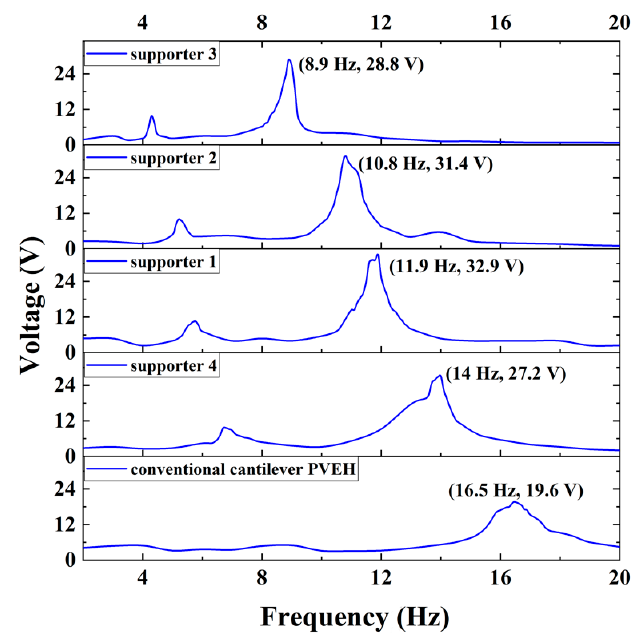
Figure 6. Open-circuit voltages of various supported.